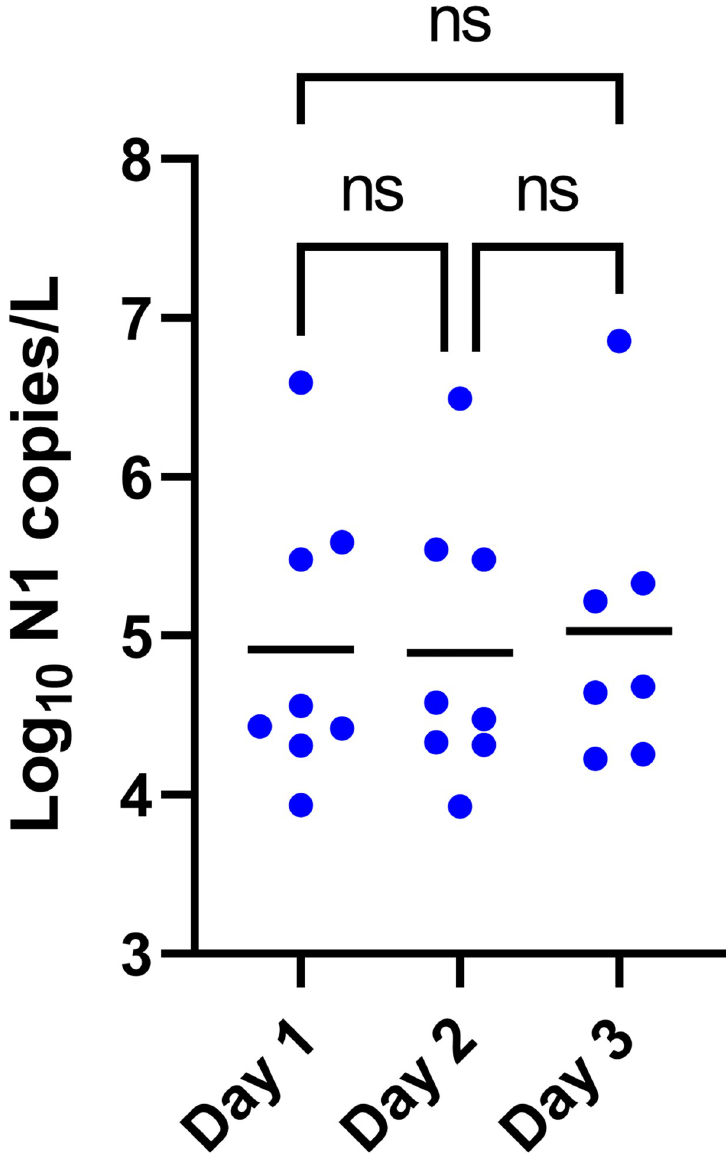
Fig 4. Effect of storage at 4˚C on unpasteurized samples: Following initial processing (pasteurization, preliminary centrifugation, and filtering), 24-hr composite samples (n = 8) were stored at 4˚C for 72 hrs. Each point is the mean of two technical replicate measurements from a 24-hour composite sample. Horizontal black lines show means. See Fig 2 legend for explanation of pairwise comparisons. https://doi.org/10.1371/journal.pone.0257454.g004 After PEG precipitation and centrifugation of the wastewater sample, the pellet is distrib- uted along the side of the centrifuge tube facing the direction of the centrifugal force, but typi- cally is not visible to the naked eye. Additionally, it takes time to dissolve the pellet in TRIzol, and premature decanting may leave residual RNA unrecovered. Therefore, untrained users often resuspend the pellet incompletely, resulting in the loss of valuable RNA. To aid in visual- izing the pellet, we added safranin at 0.2% final concentration immediately before centrifuga- tion. When safranin is added, a pale pink pellet is easily visible. Safranin staining increased yield and did not interfere with downstream processing (Fig 5; two-way ANOVA with